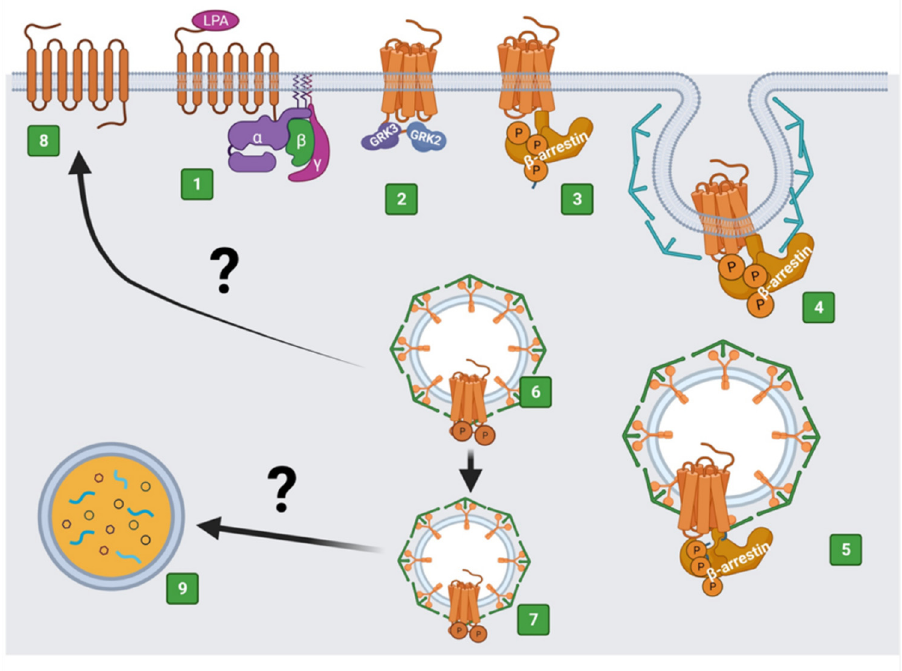
Figure 3. Internalization of agonist-activated LPA 3 receptors. (1) Activation of LPA 3 with LPA and recruitment of a G protein. (2) Exposure of GPCR phosphorylation sites. (3) Recruitment of β -arrestin through interaction with phosphorylated sites. (4) Recruitment of the endocytic machinery that initiates receptor endocytosis. (5) Endocytosis of LPA 3 via endosomes. (6) Receptor-endosomal traffic to (7) lysosomal receptor degradation or (8) receptor recycling to the plasma membrane. Question marks indicate that there is little information on these processes, which are postulated in similarity to what has been defined for other receptors. Created with BioRender.